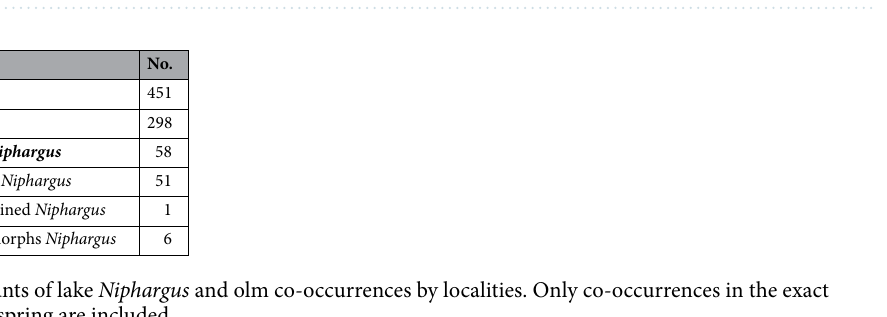
Figure 2. Distribution of all lake Niphargus species (black dots) and the detailed distribution of spined and non-spined lake species in the Dinarides. Spined lake species are present only in the depicted area of the Dinarides. Map made with QGIS version 3.10.12.